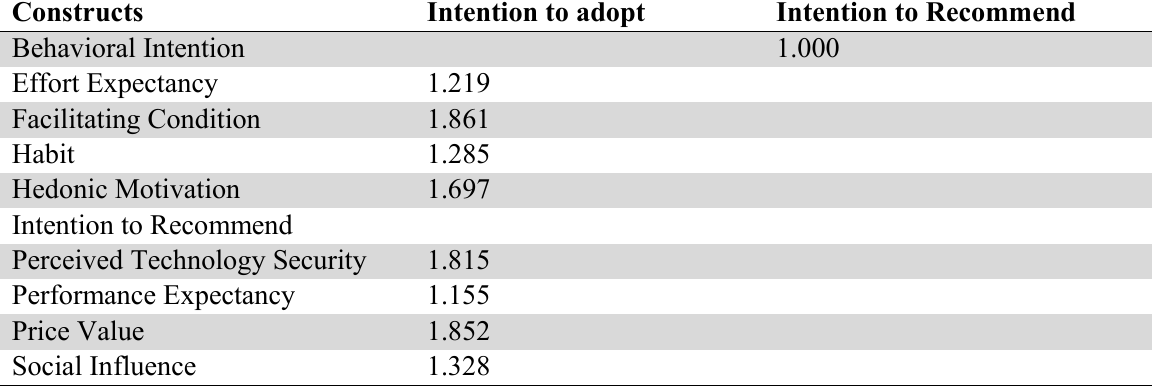
Results of Lateral Collinearity Assessment